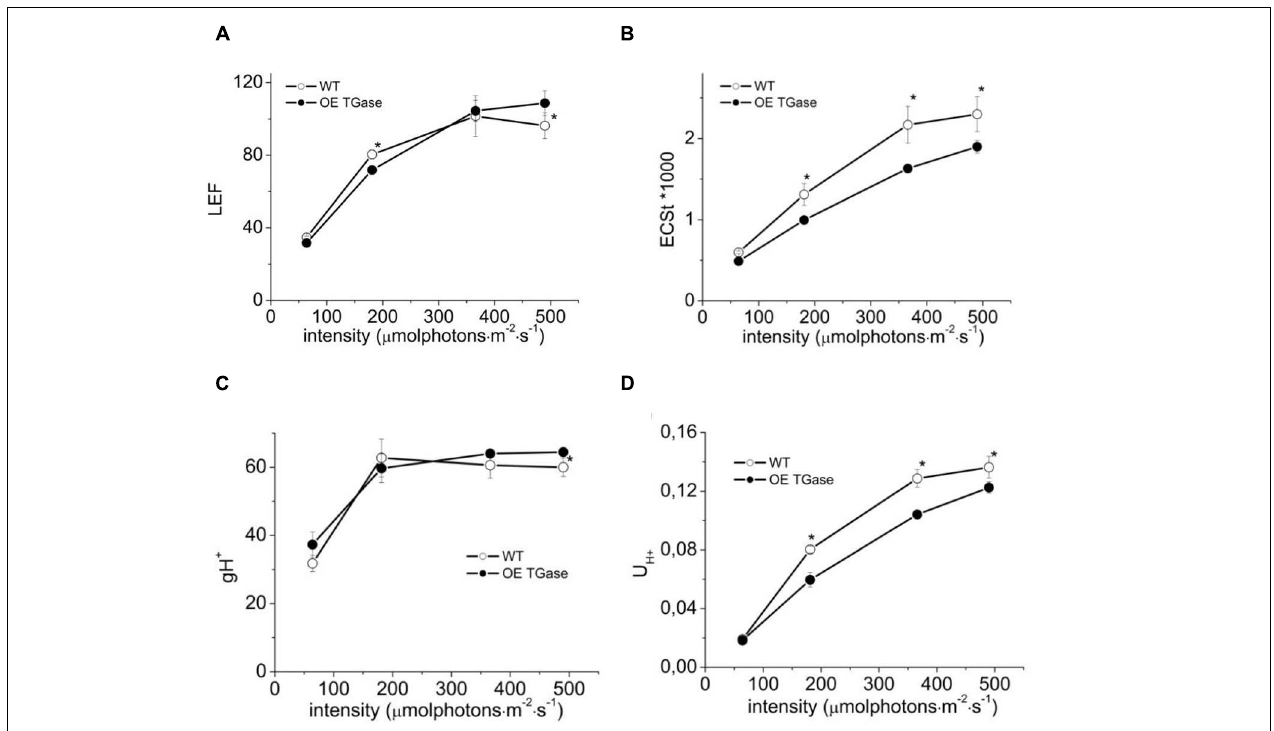
FIGURE 4 | Steady state photosynthesis in WT and OE TGase estimated in intact plants. (A) Linear electron flow (LEF) at four different light intensities. (B) Light-induced proton motive force [estimated as electrochromic shift (ECS)] in thylakoids. (C) Apparent conductivity of the thylakoidal ATPase to protons (gH + ). (D) Total proton flux from lumen to stroma (U H + ). OE TGase show relatively small differences in the proton and electron circuit of photosynthesis. Error bars denote standard error ( n = 6) and asterisks statistically significant differences ( p <